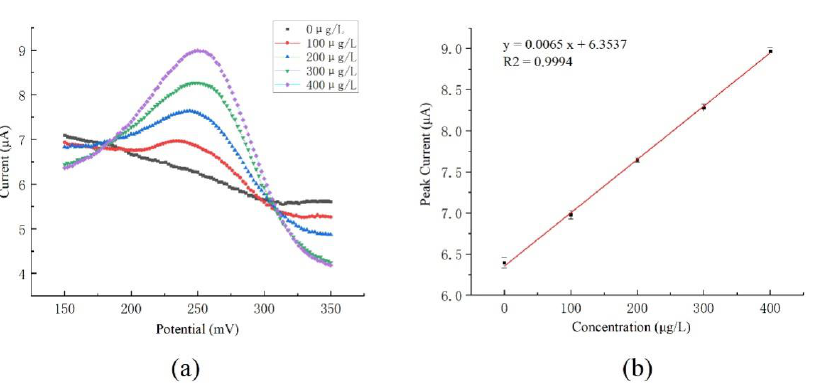
Figure 9. Cu 2+ concentration detection by columnar electrode: ( a ) Cu 2+ concentration response curve; ( b ) Cu 2+ current–concentration fitting line (The detection results are the average of three times).